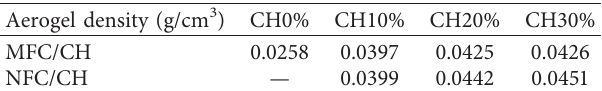
Figure 1: MFC/NFC aerogel SEM with different chitosan additions. MFC/CH ratio: (a) 100/0, (b) 90/10, (c) 80/20, and (d) 70/30; NFC/CH ratio: (e) 90/10, (f) 80/20, and (g) 70/30. Table 1: Data on the density of chitosan- (CH-) added MFC/NFC